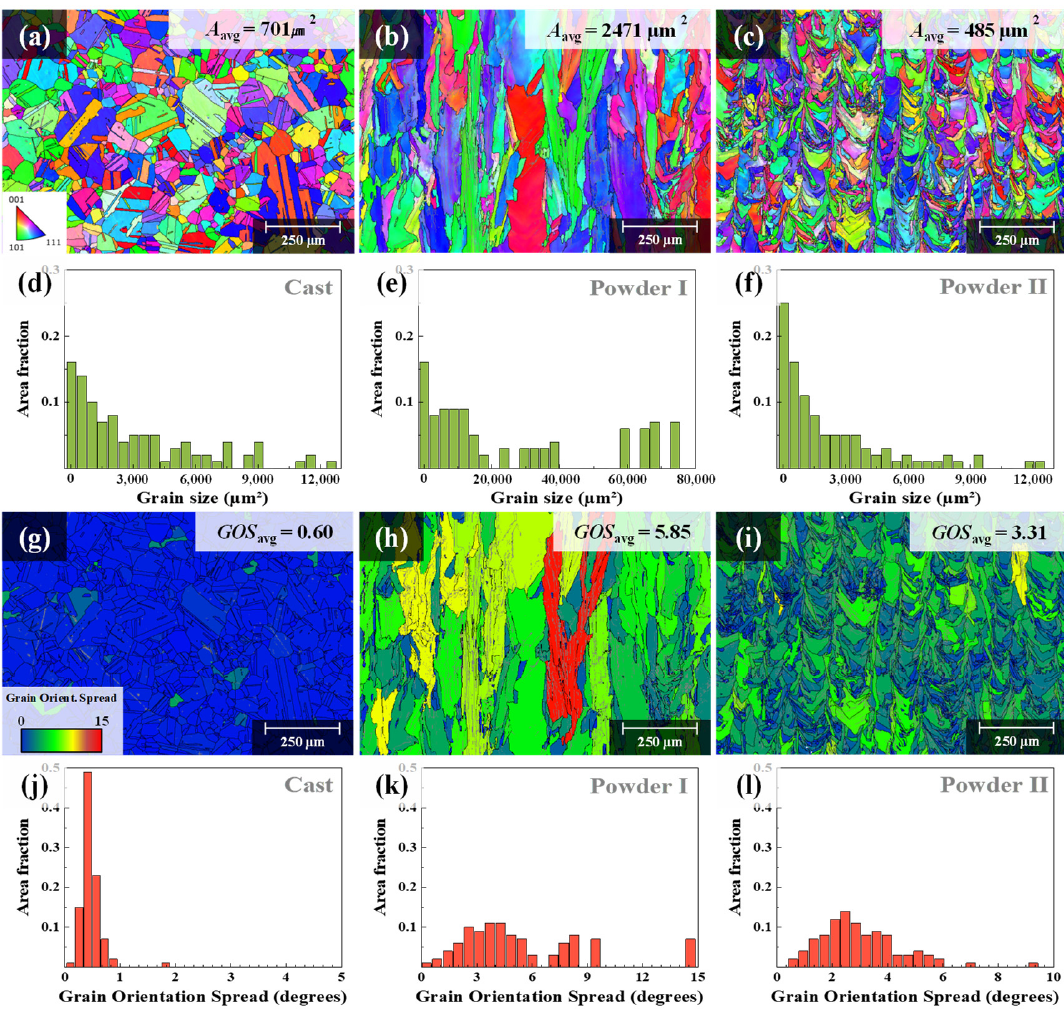
Figure 7. Electron backscatter diffraction (EBSD), inverse pole figure (IPF) and grain boundary (GB) images of building direction (vertical) plane, and the distribution of grain sizes ( a , d ) cast, ( b , e ) Powder I as-built, and ( c , f ) Powder II as-built; grain orientation spread (GOS) map and the distribution of GOS values of ( g , j ) cast, ( h , k ) Powder I as-built, and ( i , l ) Powder II as-built.